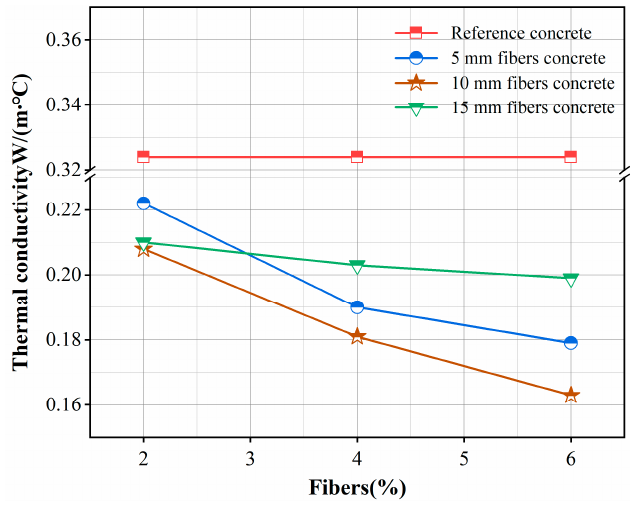
Figure 5. Thermal conductivity of fiber concrete (28 d).